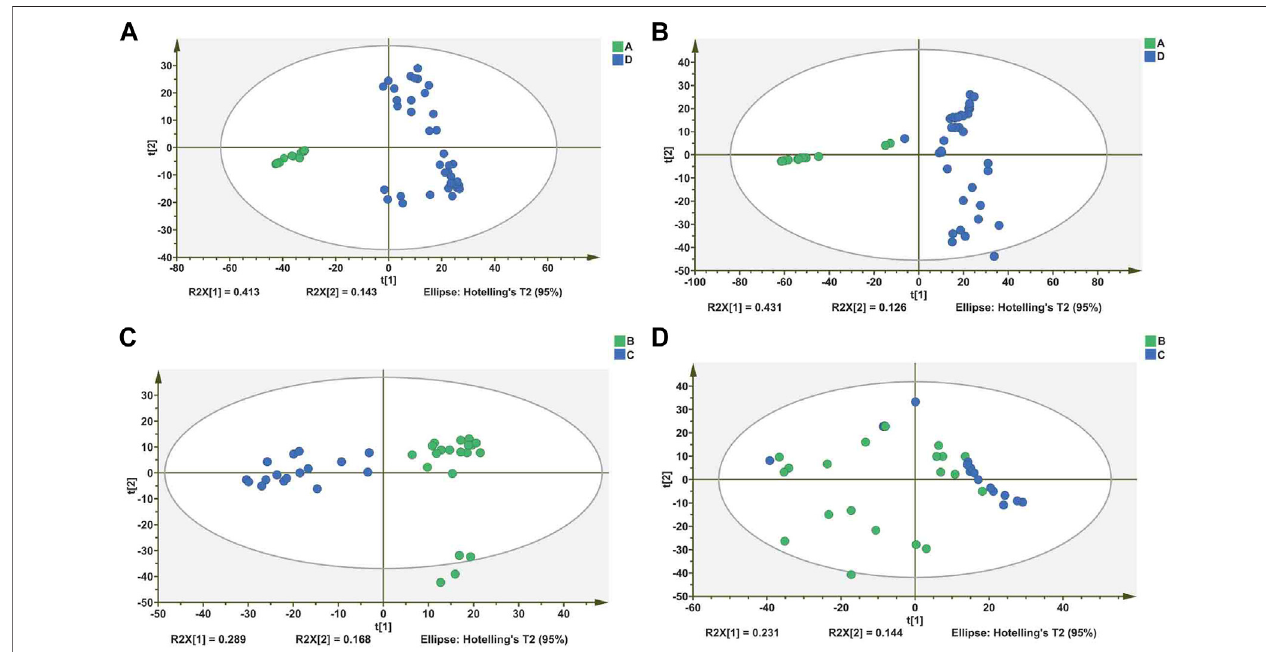
FIGURE 1 | Differentiation of metabolic pro fi les of serum of patients with different types of leukemia. (A,C) : Principal component analysis (PCA) score plots based on serum metabolic pro fi les of Acute lymphoblastic leukemia (ALL) and Acute myeloid leukemia (AML) groups in positive and negative modes. (B,D) PCA score plots based on serum metabolic pro fi les of within the AML group in positive and negative